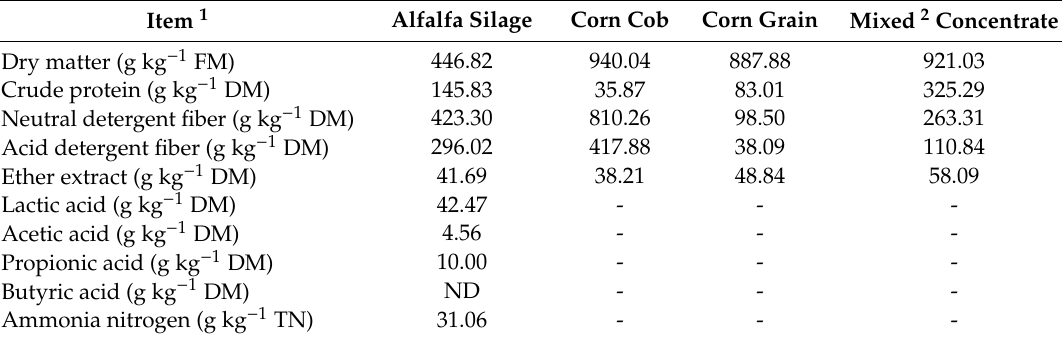
Table 1. Chemical composition and fermentation characteristics of ingredients used for the total mixed ration.